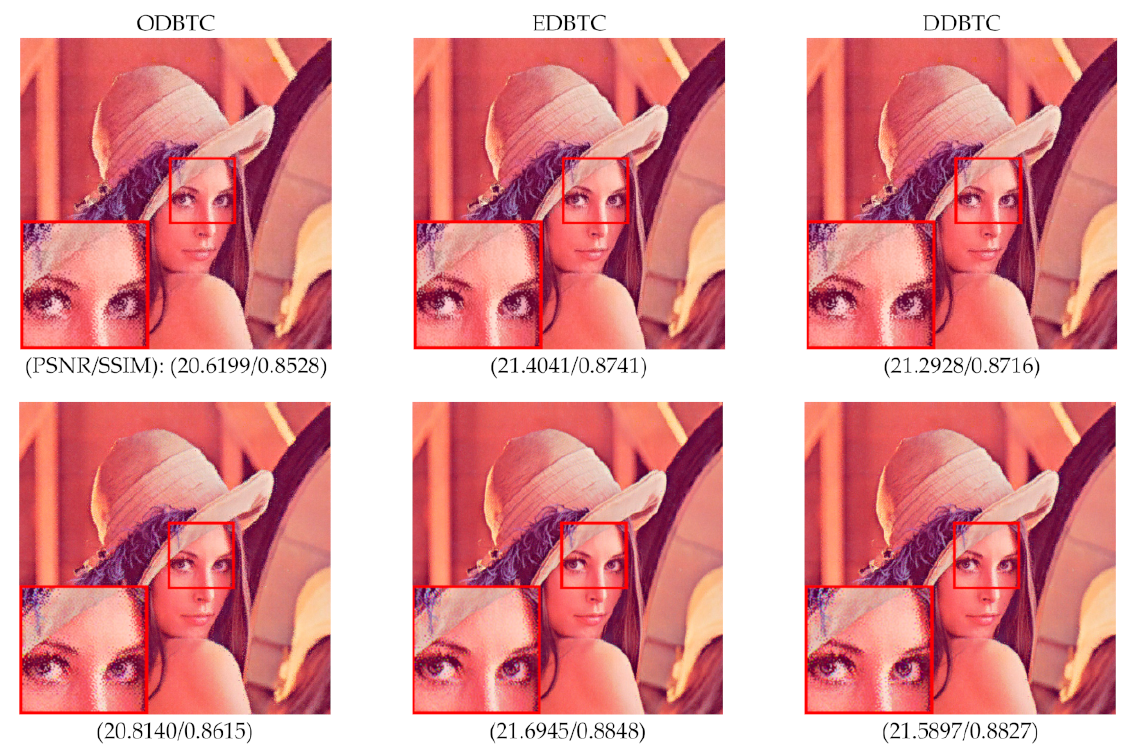
Figure 2. Visual comparisons of using single and three bitmap images on (first to last column) ordered dither block truncation coding (ODBTC), error diffusion block truncation coding (EDBTC), and dot diffused block truncation coding (DDBTC). The first and second rows are using single and three bitmap images,